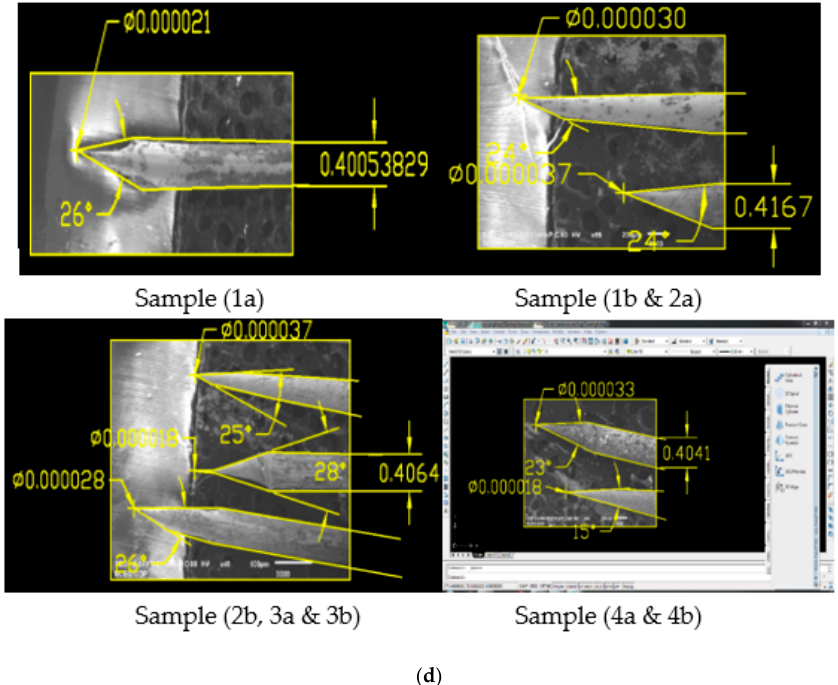
Figure 4. ( a ) SEM Images of 0.4 mm tungsten tips prepared on Meniscus etching in 2 Molar NaOH solution (16 g/200 mL); ( b ) SEM Images of 0.4 mm tungsten tips in 2 molar NaOH solution showing cone angle and tip diameter measured using AutoCAD Software; ( c ) SEM Images of 0.4 mm tungsten tips prepared on Meniscus etching in 4 Molar NaOH solution (32 g/200 mL); ( d ) SEM Images of 0.4 mm tungsten tips in 4 molar NaOH solution showing cone angle and tip diameter measured using AutoCAD Software.